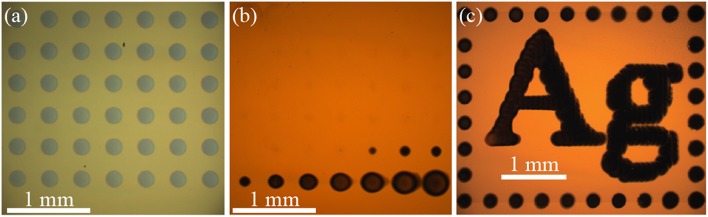
Optical micrographs of metal patterns deposited from a SBC with a 200 μm ID nozzle at 400 μL/min flowrate. (a) A 7 × 7 array of nickel grown in 0.1 mol/L NiSO4 + 0.2 mol/L ascorbic acid at 900 μA with 4,500 μC per deposit, a nozzle fly-height of 18 μm, and 400 μm deposit spacing. (b) A 7 × 7 array of silver grown in 0.05 mol/L AgNO-3 at 50 μA with 250 μC per deposit, a nozzle fly-height of 30 μm, and 400 μm deposit spacing. (c) Pattern consisting of 282 individual silver deposits grown in 0.01 mol/L AgNO3 + 0.01 mol/L FeSO4 + 0.005 mol/L Fe2(SO4)3 at 15 μA with 30 μC per deposit, a nozzle fly-height of 30 μm, and 75 μm deposit spacing.